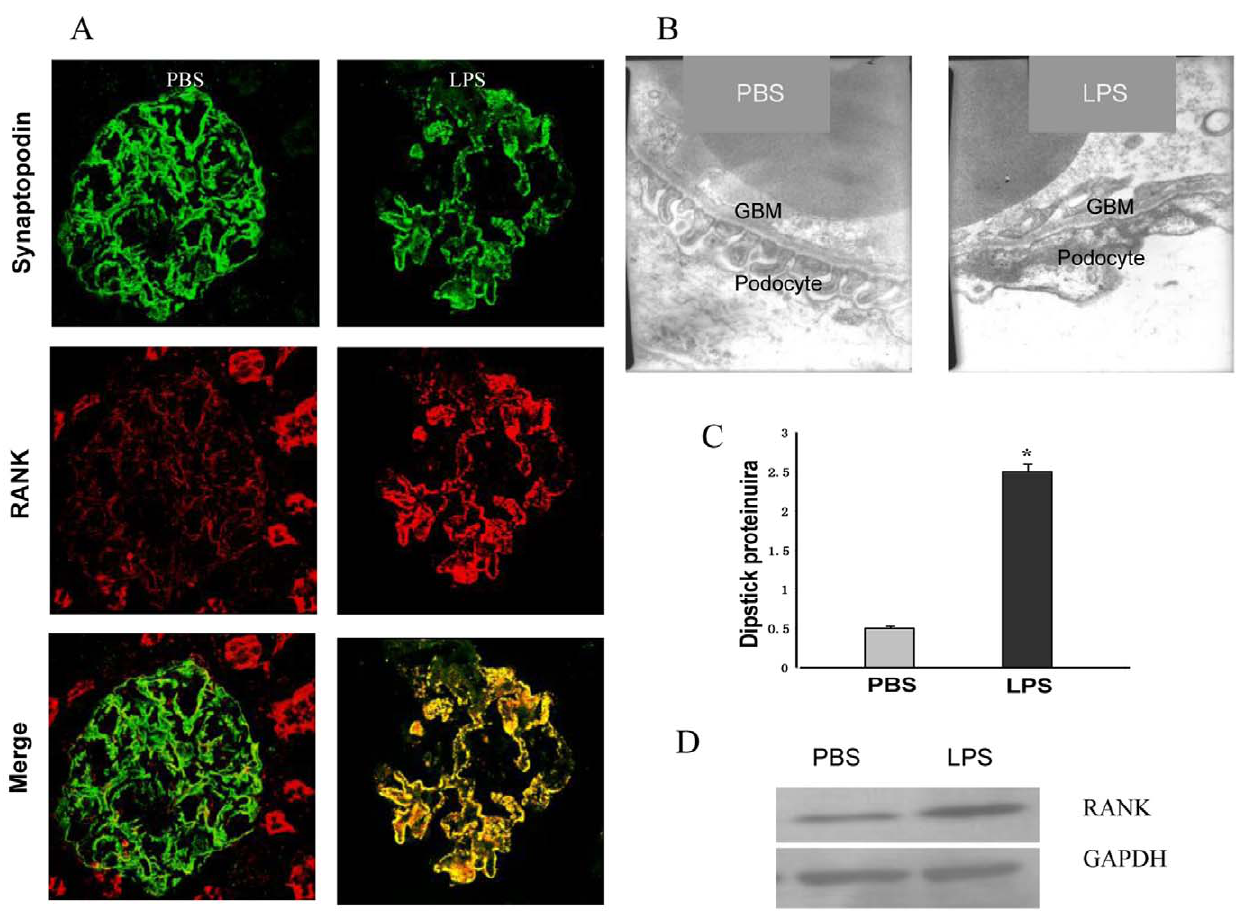
Figure 3. LPS-induced RANK was Independent of T or B Cell in SCID Mice. ( A ) LPS injection induces RANK in podocytes as shown by double labeling with synaptopodin. RANK expression (red) was low in PBS-injected SCID controls and colocalized with the podocyte marker synaptopodin (green). Mice treated with LPS, RANK expression was upregulated in podocytes, resulted in a yellow overlap with synaptopodin (Merge). ( B ) LPS injection causes severe foot process effacement within 24 h in mice, but not in PBS-injected control animals. ( C ) LPS injection causes severe proteinuria in SCID mice at 24 h (n=3; PBS control 0.5 6 0.2 versus LPS 2.5 6 0.8; p , 0.001). ( D ) RANK protein expression was determined by using Western blot analysis. RANK protein was in low abundance in the PBS group. However, RANK increased in the LPS